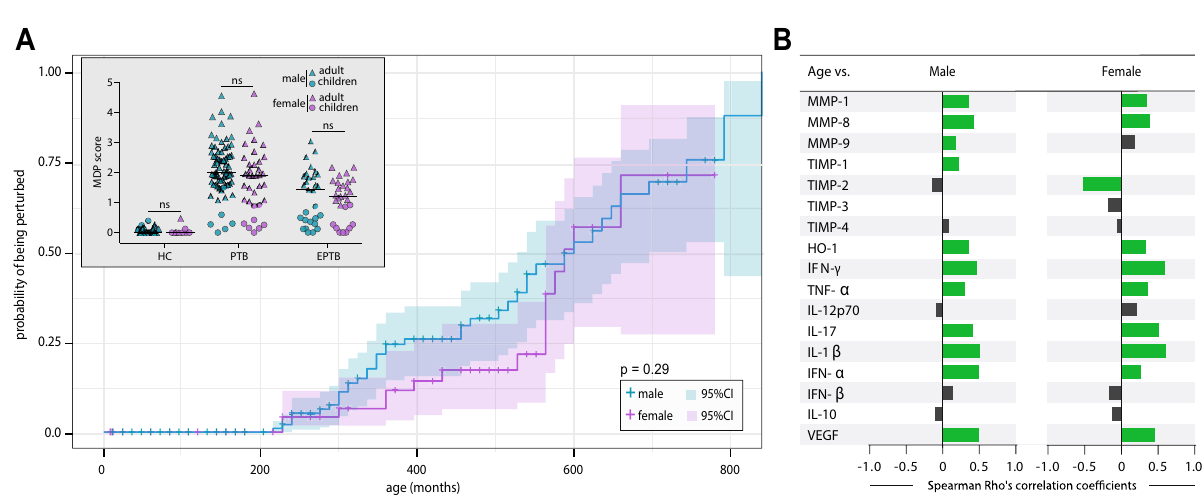
Figure 5. Molecular degree of perturbation is independent of biological sex in patients with active tuberculosis. ( A ) Perturbed probability according to the age. Spearman correlation rank was compared used Steger Method. ( B ) Spearman correlation analysis was used to test association between age and MDP values of each biomarker in either male or female TB patients. Bars represent the Spearman rank (rho) values. Colored bars indicate statistically significant correlation (P < 0.05) after adjustment for multiple